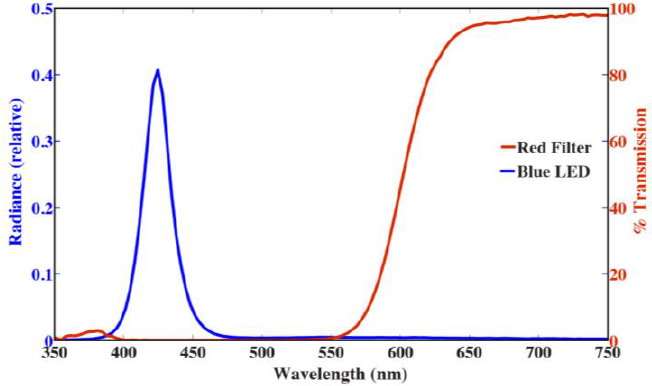
Figure 2 . Emission spectrum from LED420L and percent transmission of Roscolux filter